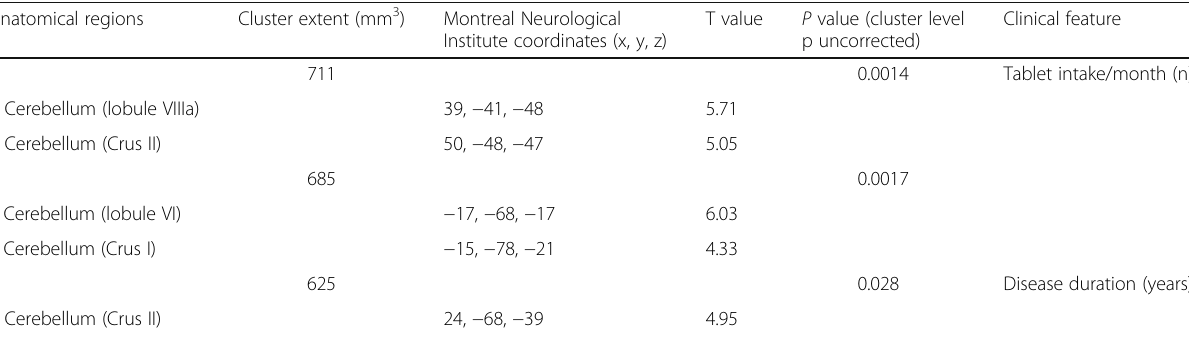
Table 4 VBM results of correlation analysis on GM morphometry with CM patients ’ clinical features at significance level of p < 0.001 (uncorrected) and adjusted for age, gender and total intracranial volume Anatomical